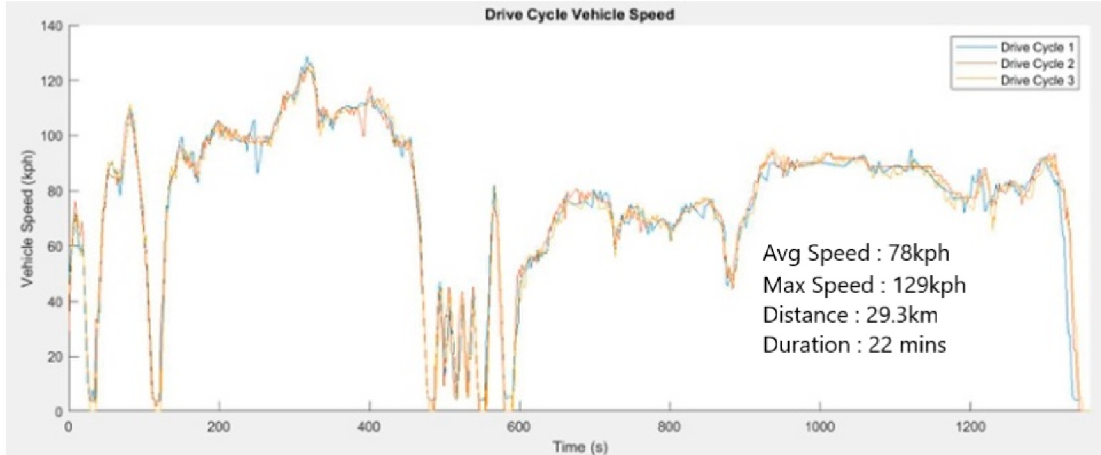
Figure 17. MCT drive cycle vehicle speed on chassis dynamometer Adapted from [18], IEEE: 2020.